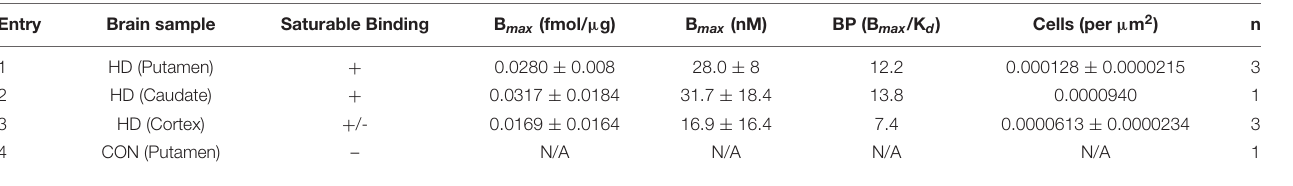
TABLE 3 | Preclinical evaluation of [ 18 F]1